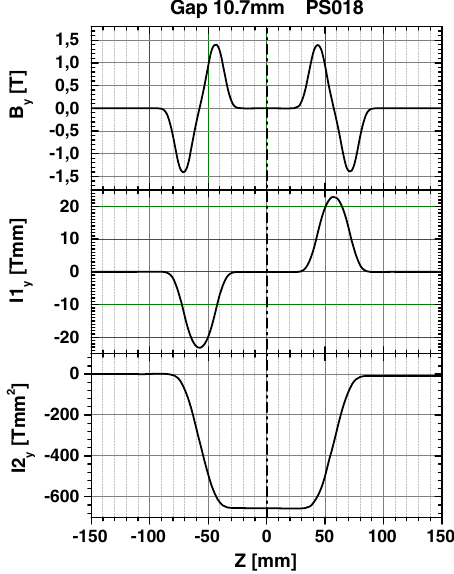
FIG. 2. Field and first and second field integrals of one of the 91 phase shifters of the European